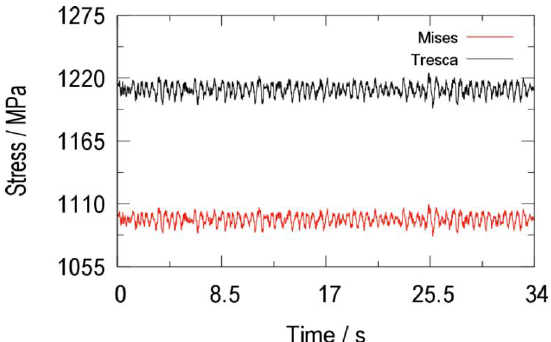
Figure 7. Typical Tresca stress distribution at the weaken groove of the explosive bolt C under Class E road.